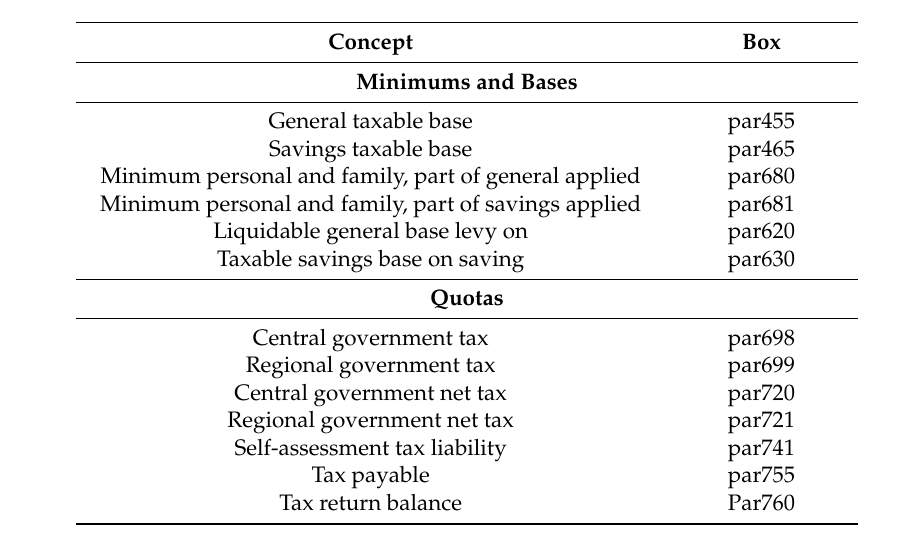
Table 2. Income tax minimum and base